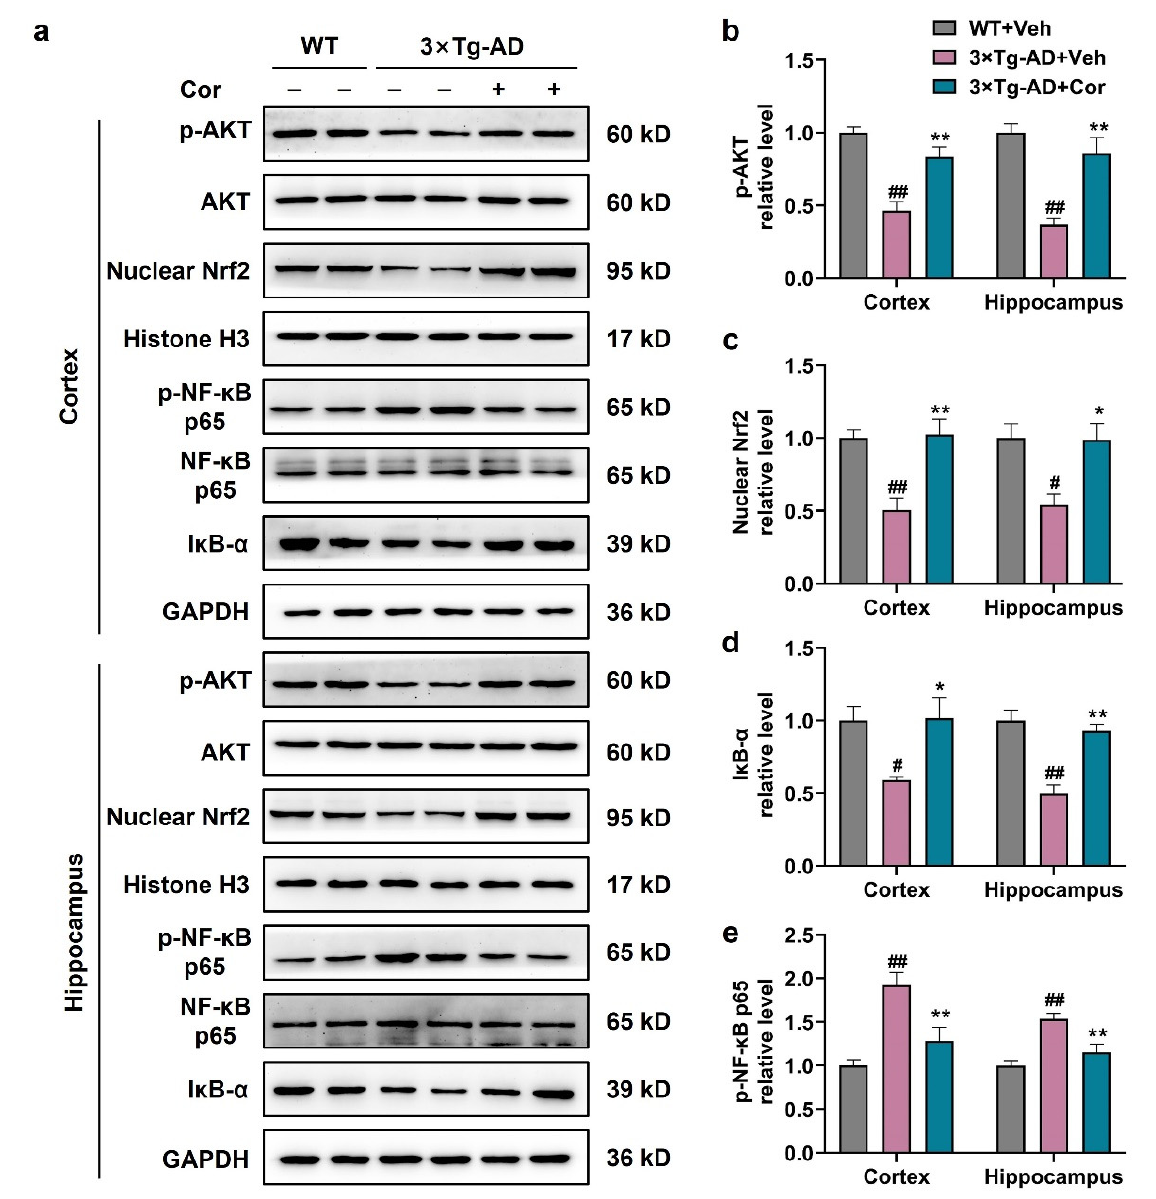
Figure 7. Cornuside activated the AKT/Nrf2 pathway and inhibited NF- κ B signaling in 3 × Tg-AD mice. ( a ) Typical WB outcomes and ( b – e ) quantitative assessments of hippocampal and cortical p-AKT, nuclear Nrf2, I κ B- α , and p-NF- κ B p65 proteins for the 3 × Tg-AD mice in the presence or absence of cornuside compared with WT mice. GAPDH or Histone-H3 was used as the control. Data are all expressed as mean ± SEM ( n = 6 in each group). # p < 0.05 and ## p < 0.01 compared with WT + Veh mice; * p < 0.05 and ** p < 0.01 compared with 3 × Tg-AD + Veh group. To clarify whether cornuside (10 µ mol/L) modifies A1/A2 astrocytic alteration